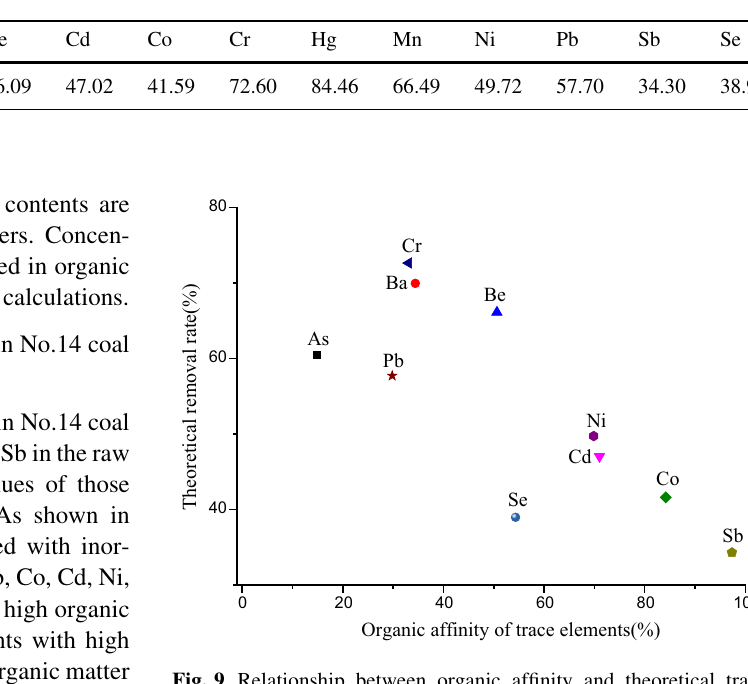
Fig. 9 Relationship between organic affinity and theoretical trace element removal rate in the No.14 coal from the Huolinhe